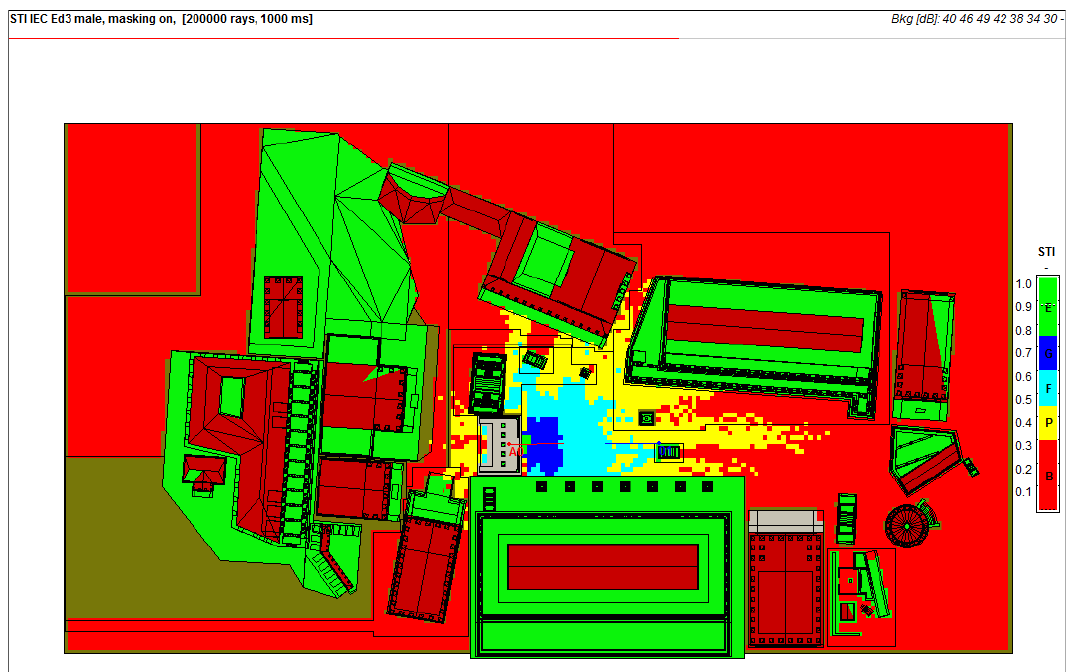
Figure 2. Results of STI analysis for speaker speaking from the Imperial Rostra with “typical audience” background noise. Green marks the area with the STI measure of 0.75–1.00 (‘Excellent’), dark blue marks the area with the STI measure of 0.60– 0.75 (‘Good’), light blue marks the area with the STI measure of 0.45–0.60 (‘Fair’), yellow marks the area with STI measure of 0.30–0.45